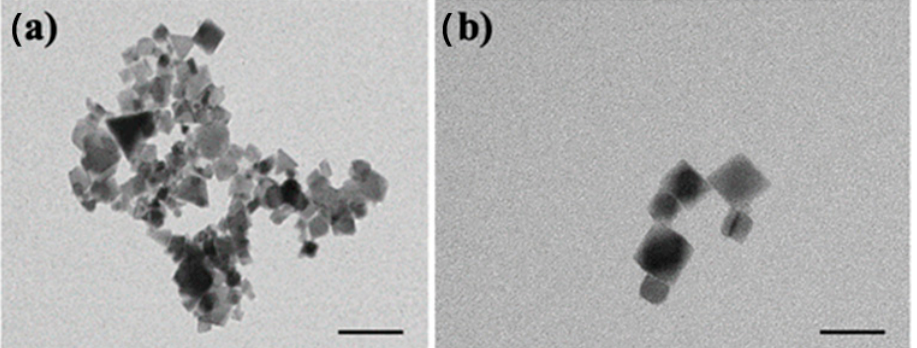
Figure 1. Images of cerium oxide nanoparticles (CeO 2 NPs) taken by transmission electron microscopy (TEM): ( a ) scale 50 nm; ( b ) scale bar 20 nm.